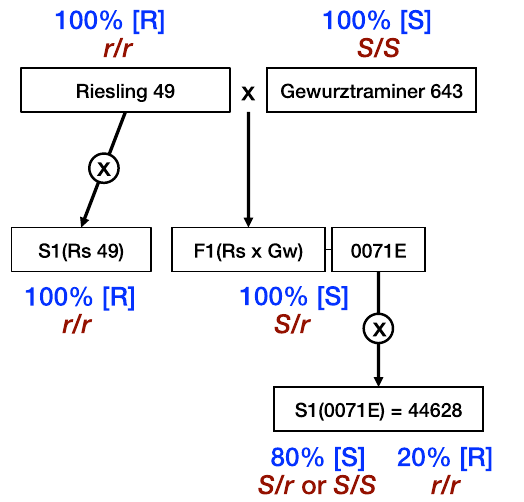
Fig. 3 Overview of the pedigrees of the populations used for genetic analysis. The resistance phenotypes observed from leaves in each population are in blue in the square brackets (R indicates resistant and S indicates susceptible), and the corresponding presumed genotypes are in dark red in italics ( r = rg fl v1 ).